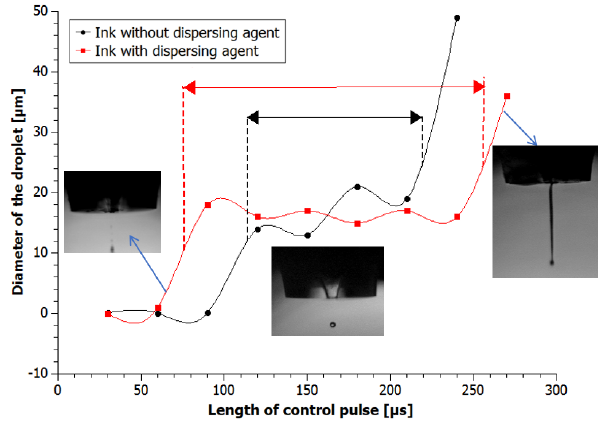
Figure 7. Diameter of inks droplets depending on the length of the pulse along with the selected technological window.